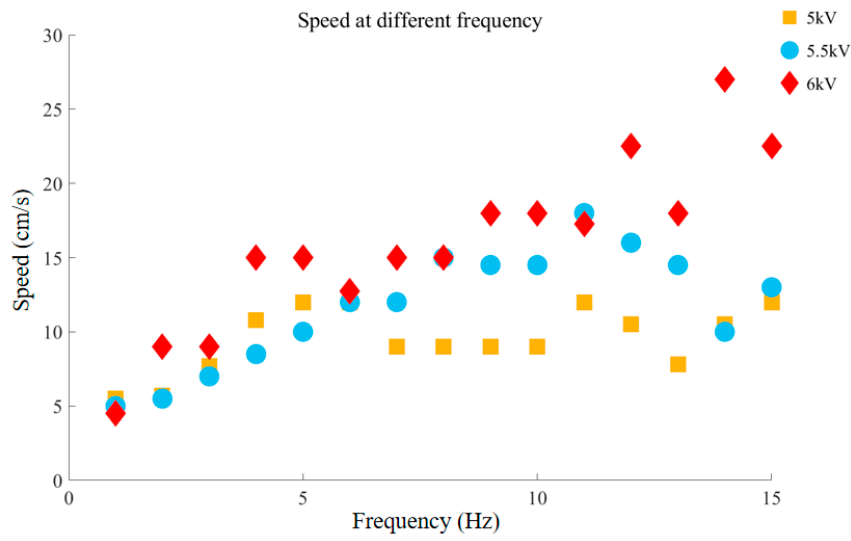
Figure 11. Comparison of forward running speed under different voltages.